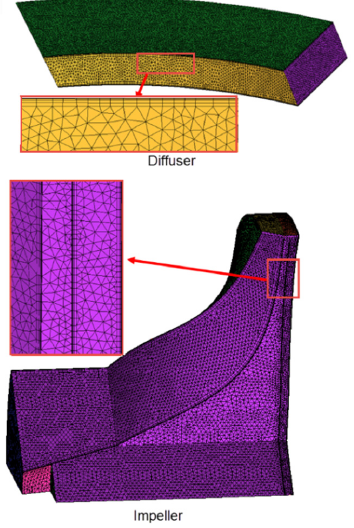
Figure 3 . Compressor grid used in the simulation.